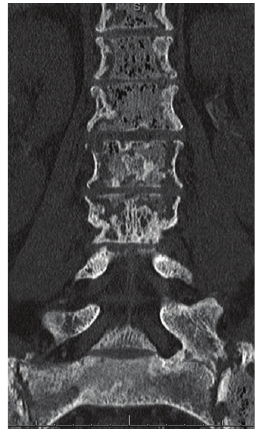
Figure 7: Coronal T2 weighted fat suppressed image of the left shoulder obtained approximately 1 year and 9 months since the initial presentation shows image findings consistent with avascular necrosis of the left humeral head. In this image, the classic double line sign with inner T2 hyperintensity and outer T2 hypointensity for osteonecrosis is well